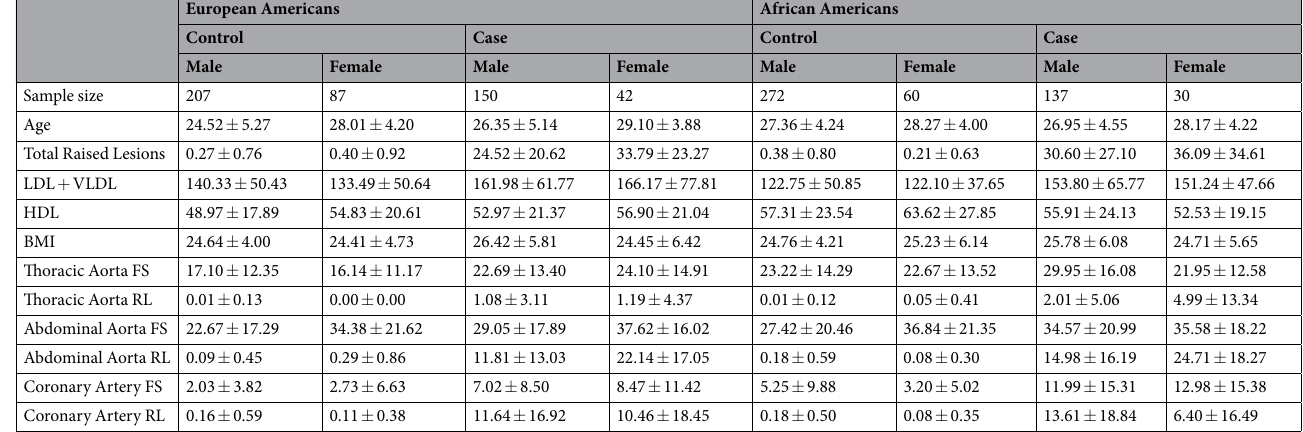
Table 1. Characteristics of PDAY subjects (FS, fatty streaks; RL, raised